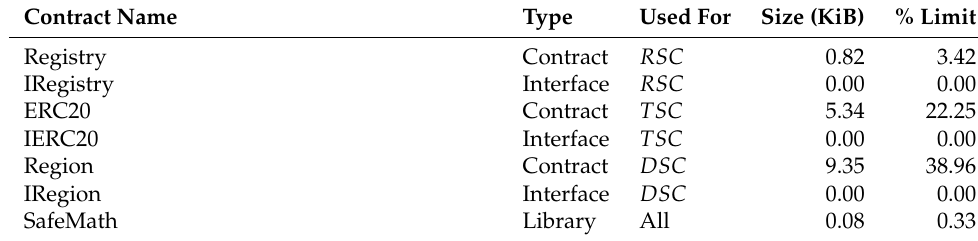
Table 6. The sizes of all deployed smart contracts. We assume the contract size limit is 24